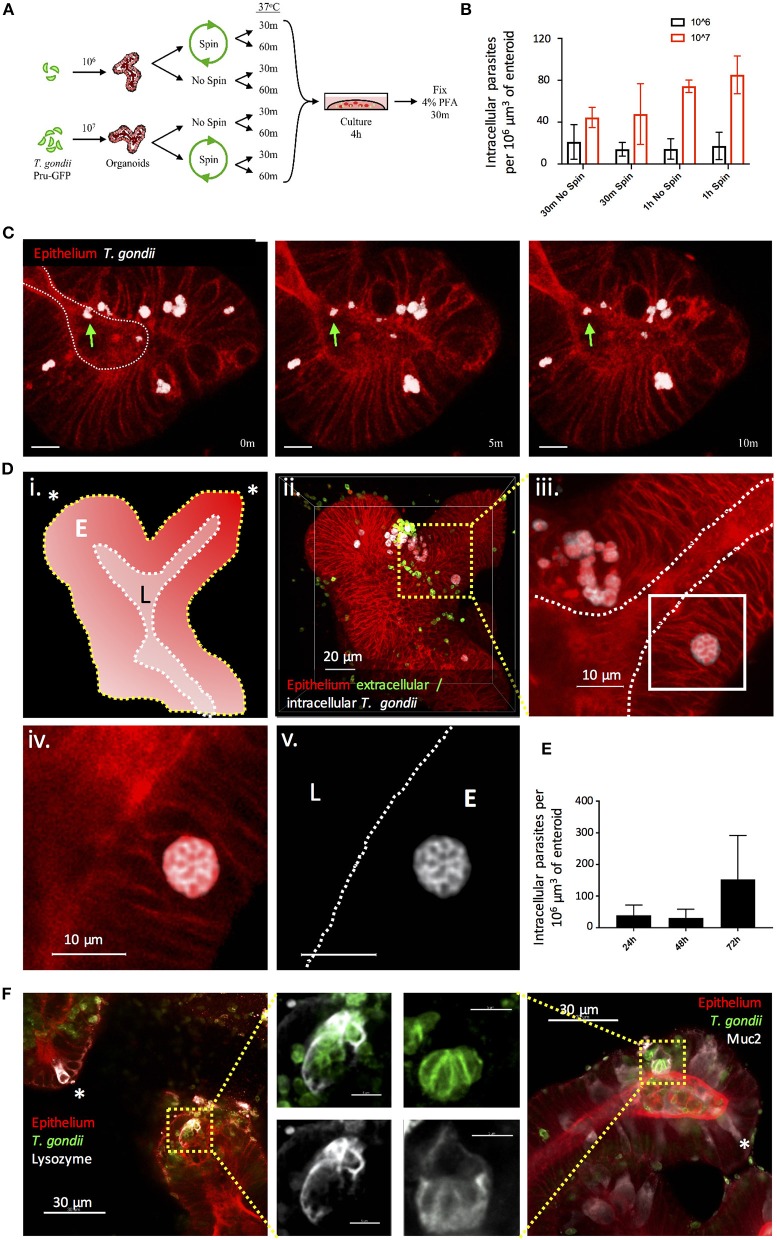
Fragmentation allows T. gondii to invade enteroids through the apical epithelial surface. (A) Schematic of the optimisation protocol for increasing the infection rate of T. gondii in enteroids. C57Bl/6 Enteroids were infected with either 106 or 107
T. gondii Pru-GFP, with or without a short spin at 2,000 rpm for 1 min. Enteroids were incubated for either 30 m or 1 h in suspension, before being plated in Matrigel and growth medium for 4 h. To quantify infection, enteroids were stained and imaged by confocal microscopy. (B) Graph depicts the number of infection events per 106 μm3 of enteroid, as defined by the presence of a parasite enclosed within host cell f-actin (phalloidin) staining. Data are pooled from three independent experiments (for each experiment, one data point representing the mean of two wells per condition, and three images captured per well, is plotted). Mean ± SEM is shown. (C) Enteroids from ROSAmT/mG mice were infected with T. gondii Pru-tdTom-Cre for 24 h and imaged by 2-photon microscopy. The images depict three time points from a time-lapse movie, showing that viable T. gondii were present within the enteroid lumen (green arrows). White dotted line represents apical (lumenal) surface. Scale bar 10 μm. Corresponds to Supplementary Video 1. Note that T. gondii PRU-tdTom-cre and ROSAmT/mG epithelium both express tdTomato. Parasites, defined by morphology and higher fluorescence intensity, have been pseudocoloured white in Imaris. (D) ROSAmT/mG enteroids were infected with T. gondii Pru-tdTom-Cre and incubated for 72 h before fixing and staining with an antibody to the SAG1 membrane protein of T. gondii (clone TP3). Z-stack images were acquired by confocal microscopy and analyzed using Imaris. (i) Schematic representation of enteroid. White dotted line represents apical surface, yellow dotted line represents the basal surface. Asterisk represents crypt base. E is epithelium, L is lumen. (ii) The surfaces and mask functions in Imaris were used to separate the SAG1 signals derived from intracellular (white) and extracellular (green) parasites into two separate channels. (iii–v) The inset shows a rosette of replicating parasites E is epithelium, L is lumen. (E) Graph depicts intracellular parasites per enteroid volume over a 72 h period of infection. Pooled data from two independent experiments (for each experiment, one data point representing the mean of two wells per condition, and three images captured per well, is plotted). Mean ± SEM is shown. (F) C57Bl/6 Enteroids were infected with T. gondii RH (green) and stained for Paneth cells (Lysozyme, white) and goblet cells (Muc2, white). Examples of uninfected Paneth or Goblet cells are indicated with asterisks. White dotted lines indicate apical surfaces of the epithelium throughout.